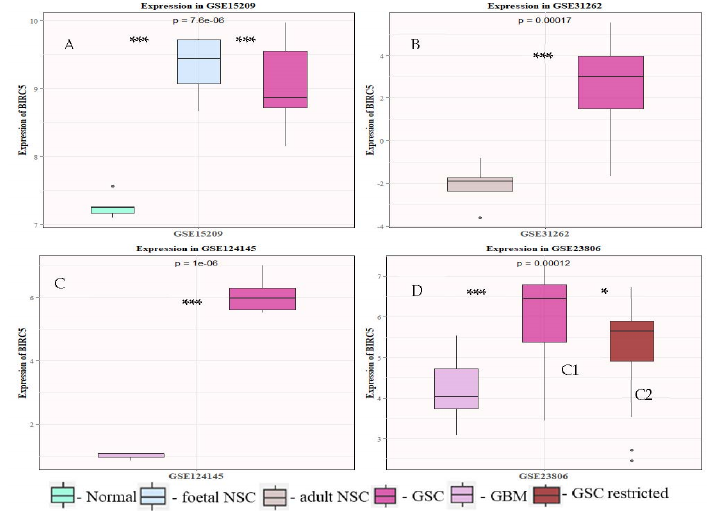
Figure 2. Differential expression of BIRC5 in GSC samples obtained from 4 different datasets: ( A ) GSE15209 showing expression in normal brain, GSCs and fNSCs; ( B ) GSE31262 for aNSC and GSC; ( C ) GSE214145 hGBM and GSC; and ( D ) GSE23806 primary GBM and GSC lines isolated from them. The graphical data are presented as mean ± SD, and the statistical analysis was performed using one-way ANOVA (*: p -value < 0.05; ***: p -value < 0.001).